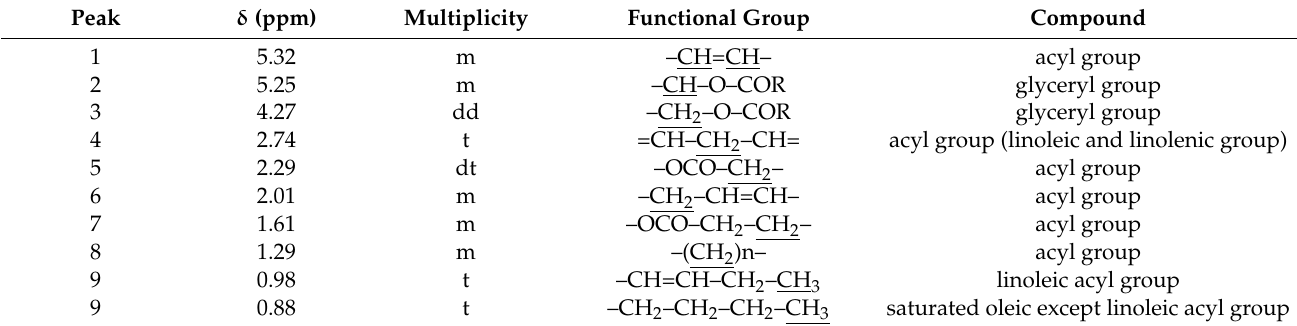
Table 5. Chemical shift assignment of 1 H-NMR for FAs.